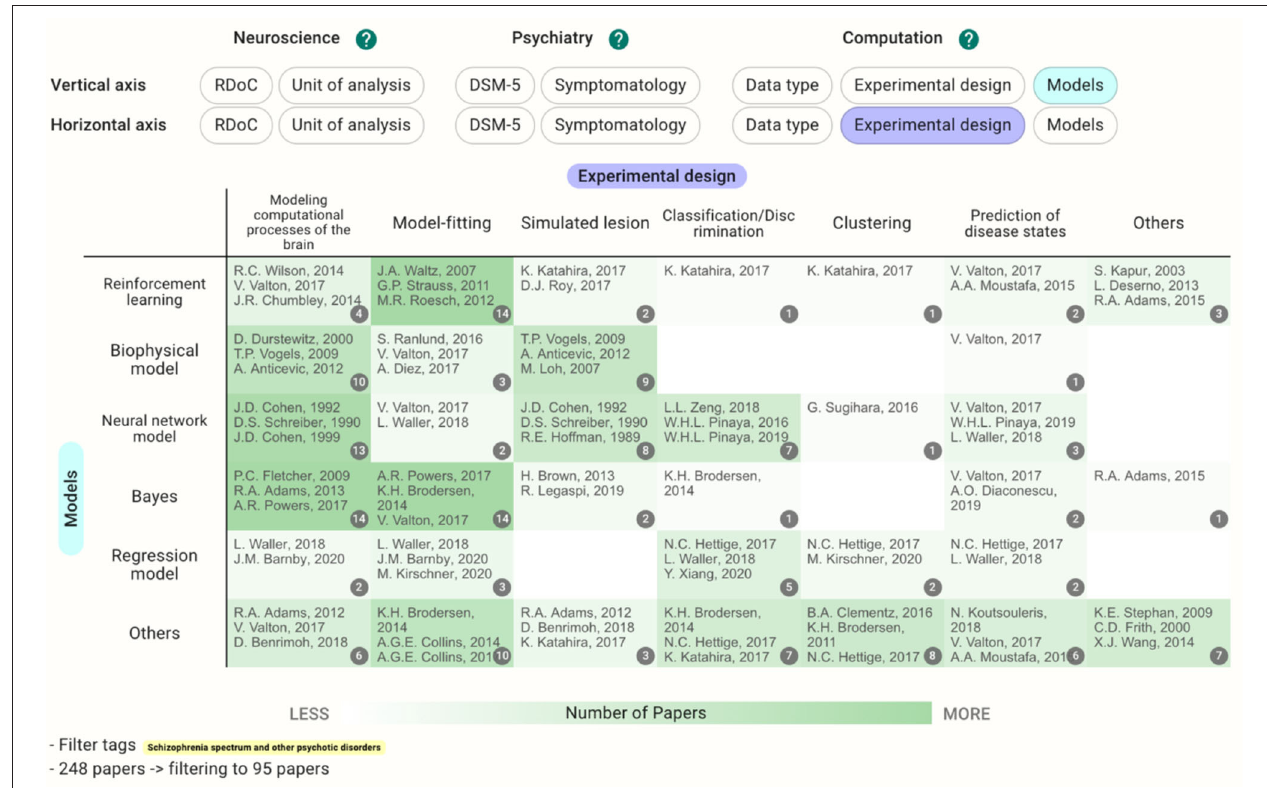
FIGURE 6 | Heatmap with models and experimental design as the vertical and horizontal axes, respectively, as in Figure 5 . However, this map was filtered by DSM-5 category, schizophrenia spectrum, and other psychotic disorders.